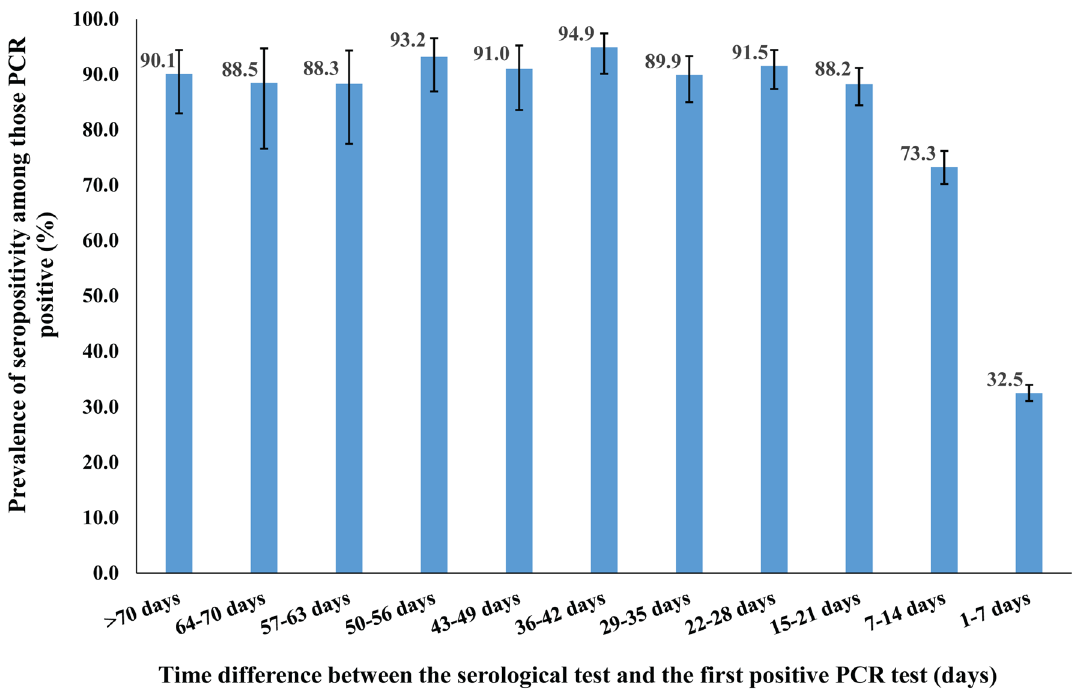
Figure 1. Anti-SARS-CoV-2 prevalence assessed at different time intervals for the duration between the first PCR positive test and the antibody test. PCR polymerase chain